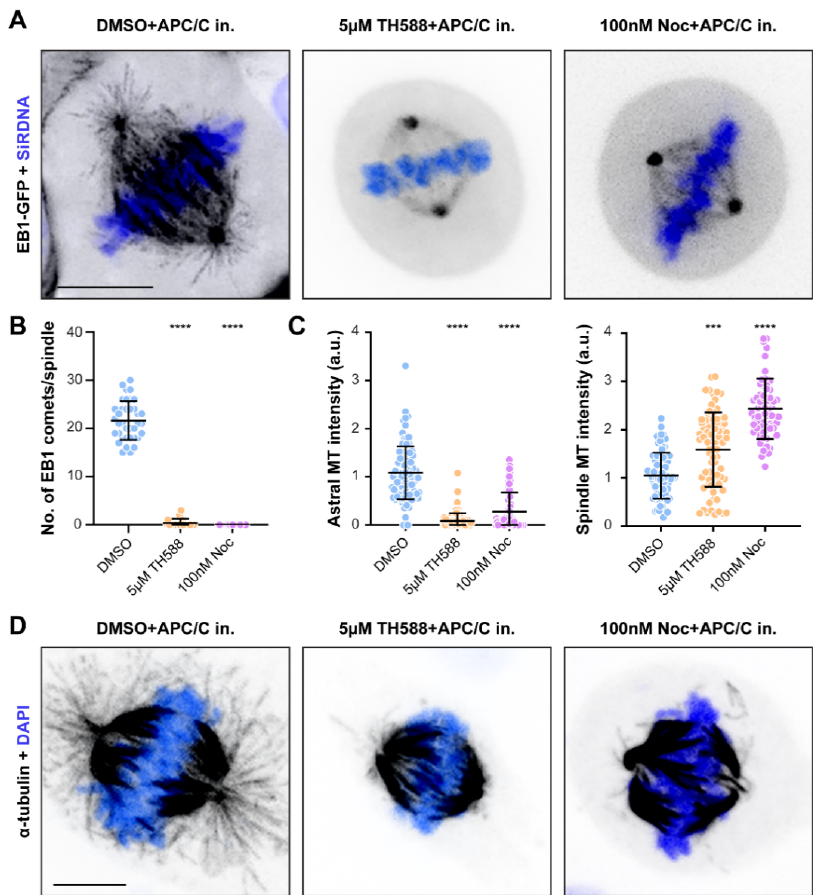
Figure 3. Both TH588 and low-dose nocodazole disrupt a more dynamic array of astral MTs, while stabilizing longer-lived kinetochore-MTs. ( A ) Representative temporal projection of metaphase ar- rested mitotic spindles of U2OS EB1-GFP cells undergoing specified treatment. DNA counterstained with SiR-DNA shown in blue. Scale bar 10 µ m. Scatter plots with mean and SD are plotted from three independent experiments. ( B ) Quantification of the number of EB1 comets per mitotic spindle in metaphase arrested cells (n = 37 cells for DMSO, 37 cells for 5 µ M TH588, and 36 cells for 100 nM nocodazole). ( C ) Immunofluorescence-based quantification of astral and spindle MT population intensities in metaphase-arrested mitotic cells undergoing indicated treatments. (n = 76 cells for DMSO, 80 cells for 5 µ M TH588, and 66 cells for 100 nM nocodazole). ( D ) Representative images of metaphase-arrested U2OS mitotic spindles immunostained with α -tubulin antibody undergoing indicated treatments (quantified in C ). DNA was counterstained with DAPI (blue). Scale bar 10 µ m. *** p < 0.001, **** p <